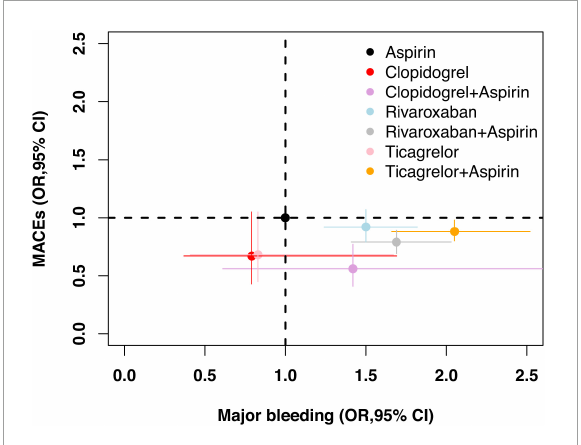
FIGURE4 Net clinical benefit. OR of different antithrombotic strategies in comparison with aspirin (reference) and associated 95% CI are plotted. Major bleeding is on the x -axis and MACEs is on the y -axis. CI, credible intervals; MACEs, major adverse cardiovascular and cerebrovascular events; OR, odds